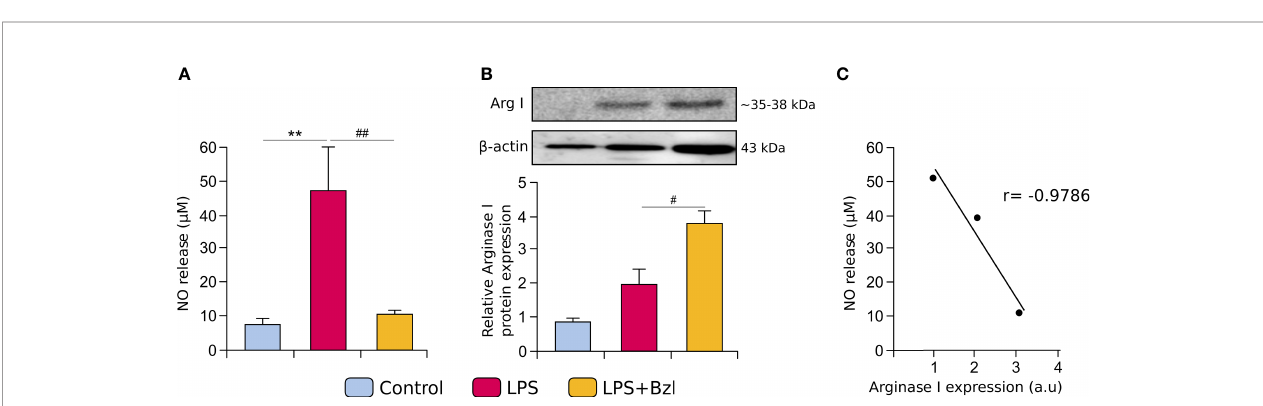
FIGURE 4 | RAW 264.7 macrophages were treated with 15 µM of Bzl for 30 minutes and then with 10 µg/mL of LPS. After 48 h, NOx levels were quanti fi ed by the Griess reaction in culture supernatants (A) and relative Arginase I (~35-38 kDa) protein expression was determined by Western blot with a speci fi c antibody and normalized against b -actin (43 kDa) (B) . Relationship analysis between NOx release and Arginase I expression was performed using a Pearson rank-order correlation test and Pearson correlation coef fi cient (r) is reported (Power=0.8) (C) . Results are expressed as the mean of 3 independent experiments (n=3, 5 replicates/ treatment) ± SEM. ** P < 0.001 vs. control cells; # P < 0.05, ## P < 0.001 vs LPS-stimulated